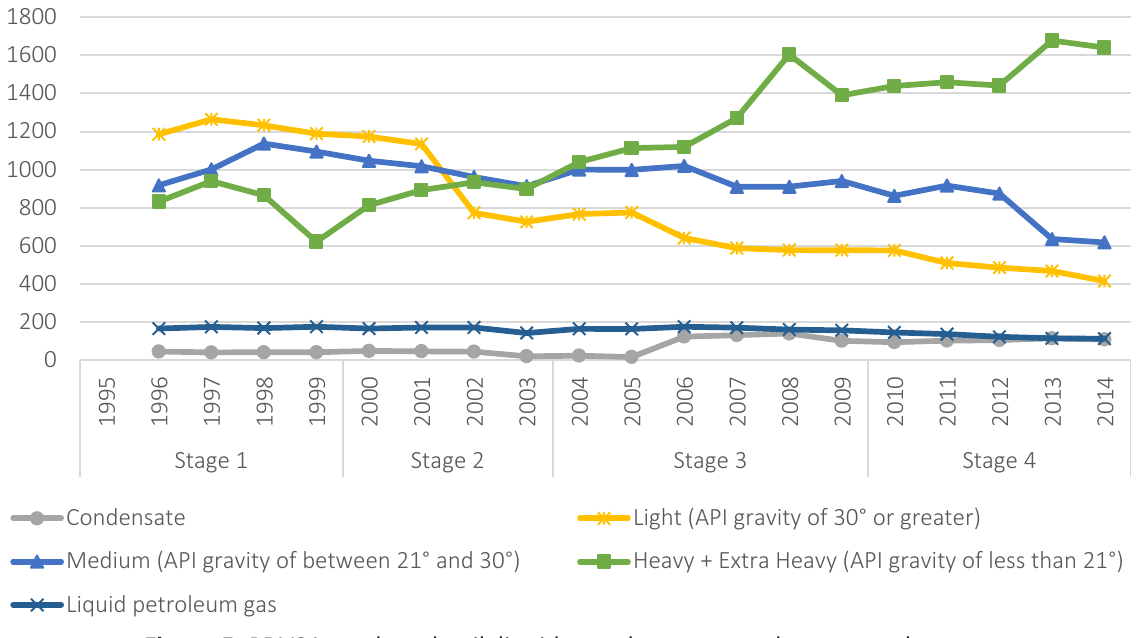
Figure 5. PDVSA total crude oil, liquid petroleum gas, and net natural gas (in thousands of BOE per